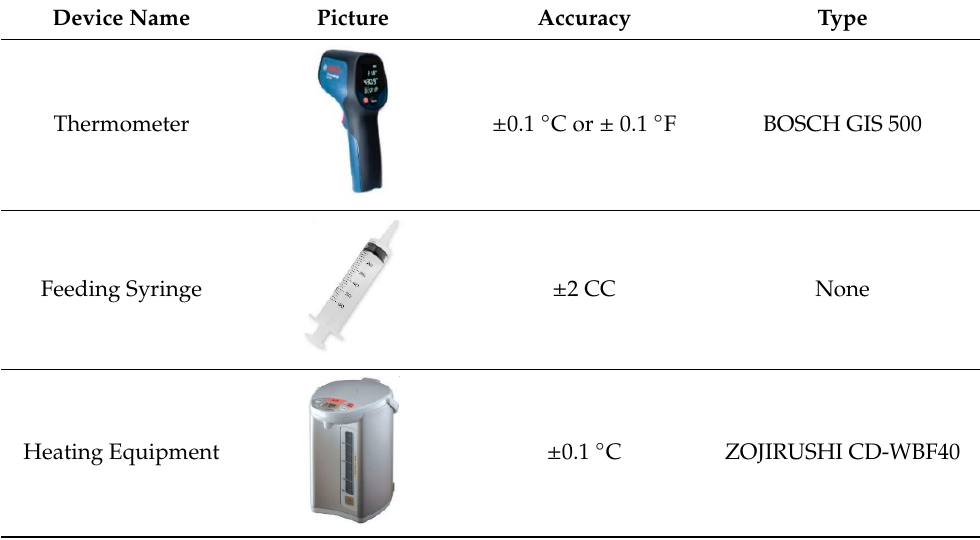
Table 2. List of instruments adopted for this experiment.